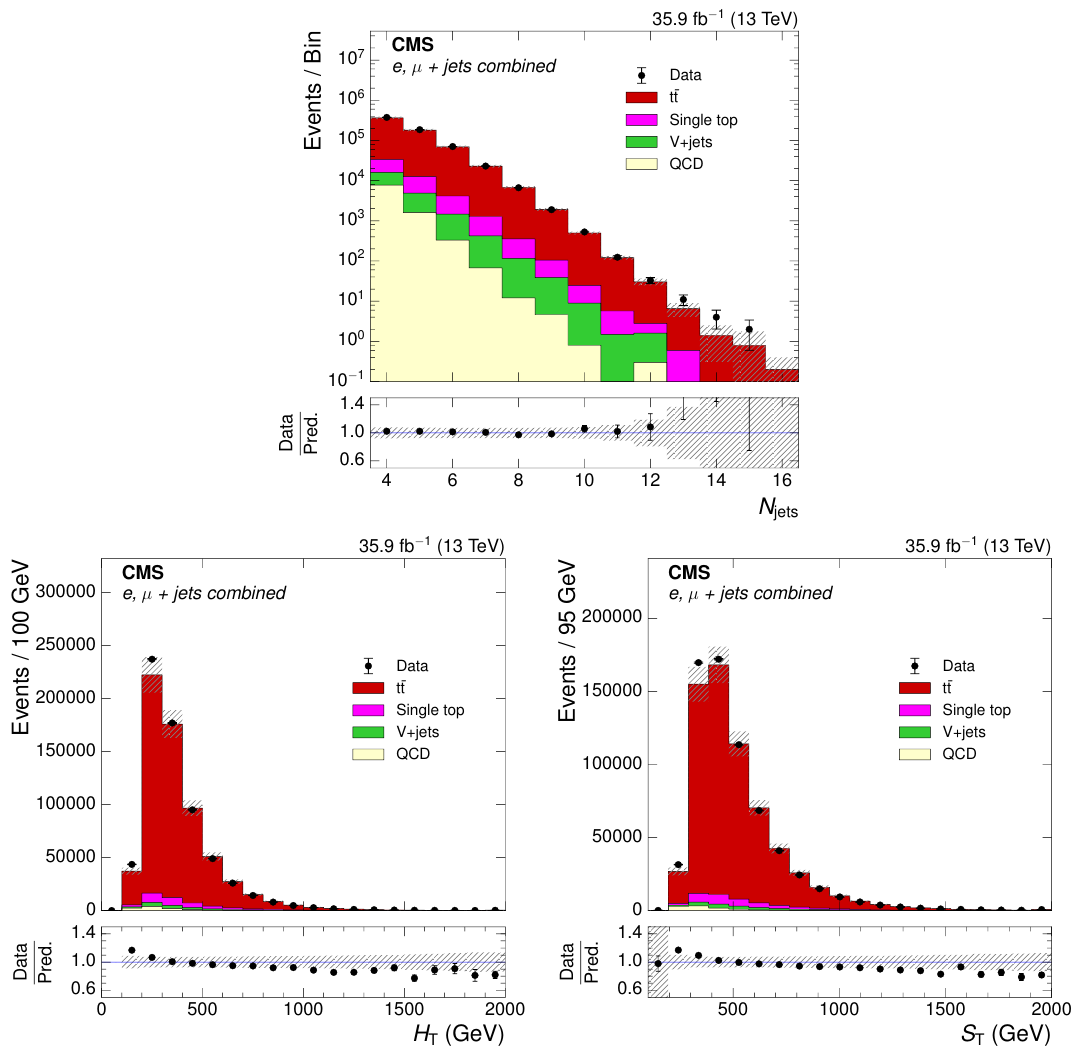
Figure 1 . The distributions of N jets , H T and S T after full event selection. The tt simulation is normalized to the NNLO prediction. The ratio of the number of events in data to that in simulation is shown below each of the distributions, with the statistical uncertainty in the data shown by the vertical uncertainty bars. The statistical uncertainty in the number of simulation events and the uncertainties in the modeling in simulation are shown by the hatched